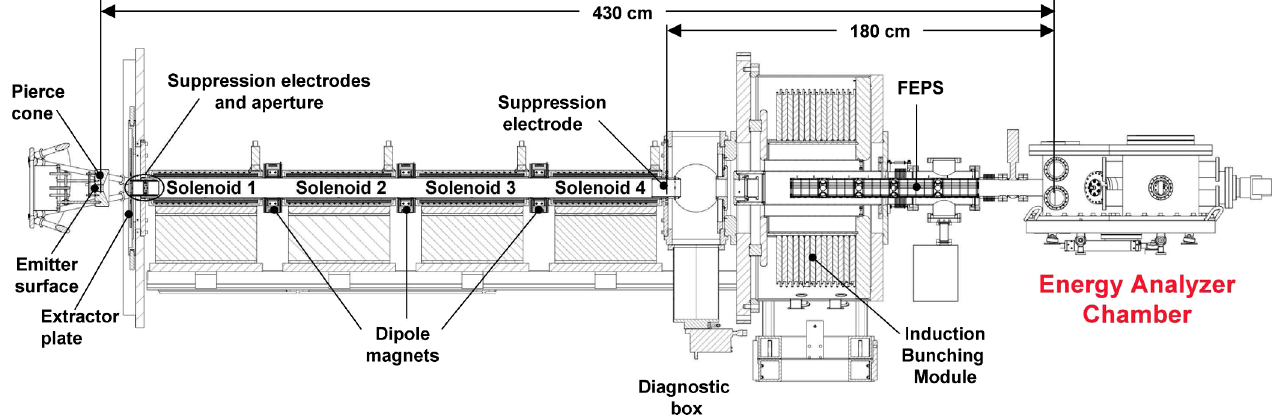
FIG. 1. Elevation view of the NDCX with the EEA added on at the exit of the FEPS.